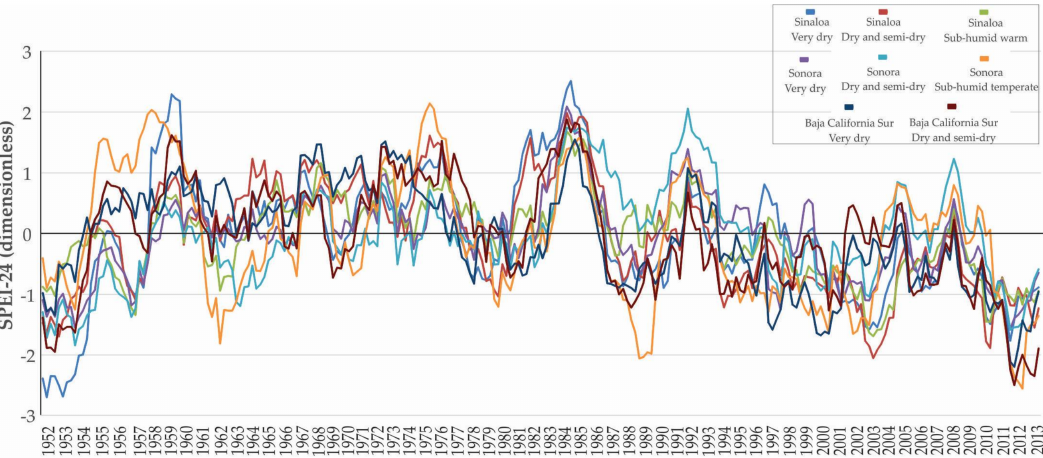
Figure 5. Seasonal variation of SPEI-24 by climate region in states in northern Mexico (Sinaloa, Sonora and Baja California Sur) in the period 1952–2013 (dimensionless). Source: Authors, following SPEI database (http://sac.csic.es/spei/) and INEGI climatic classification (http://www.cuentame.inegi.org.